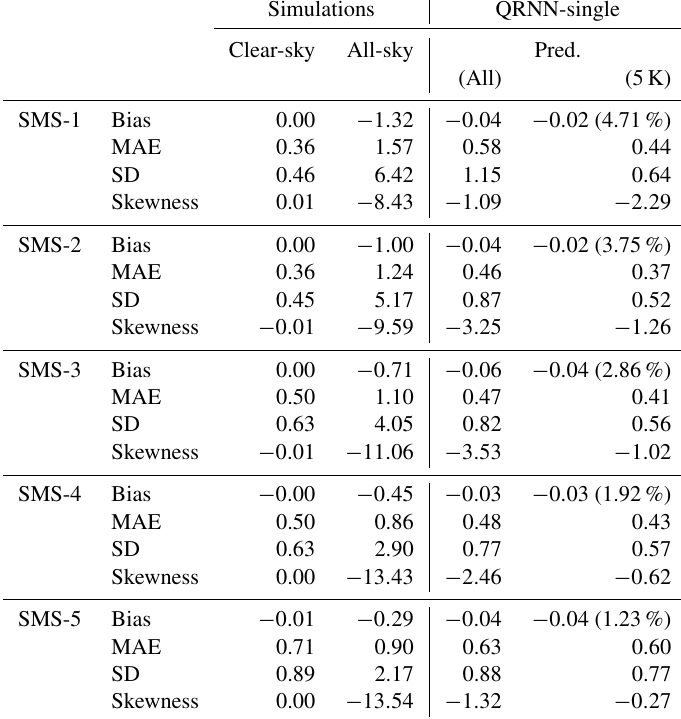
Table 7. Same as Table 5 but from QRNN-single for SMS channels. The fraction of rejected cases is given in parentheses.